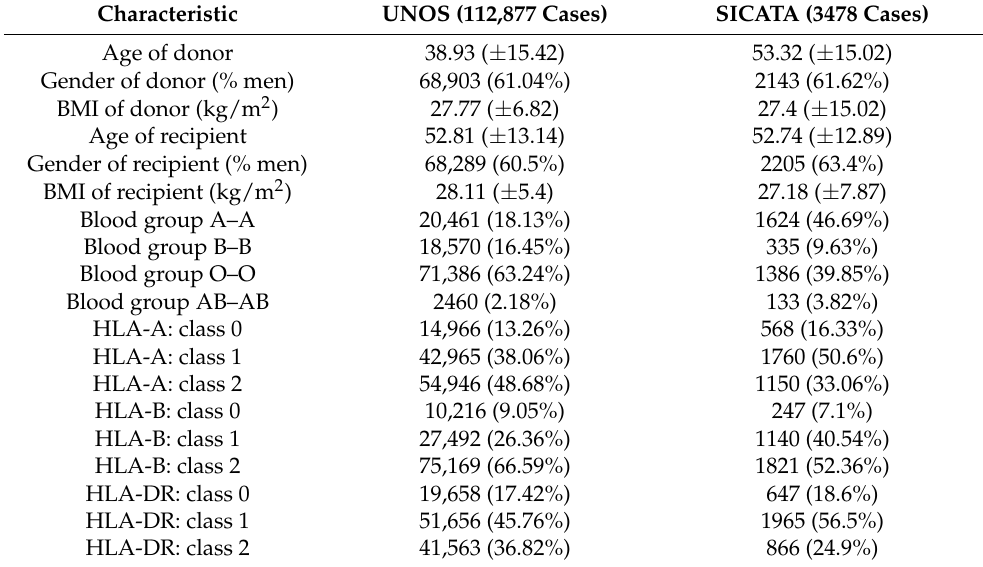
Table 1. Donor and recipient